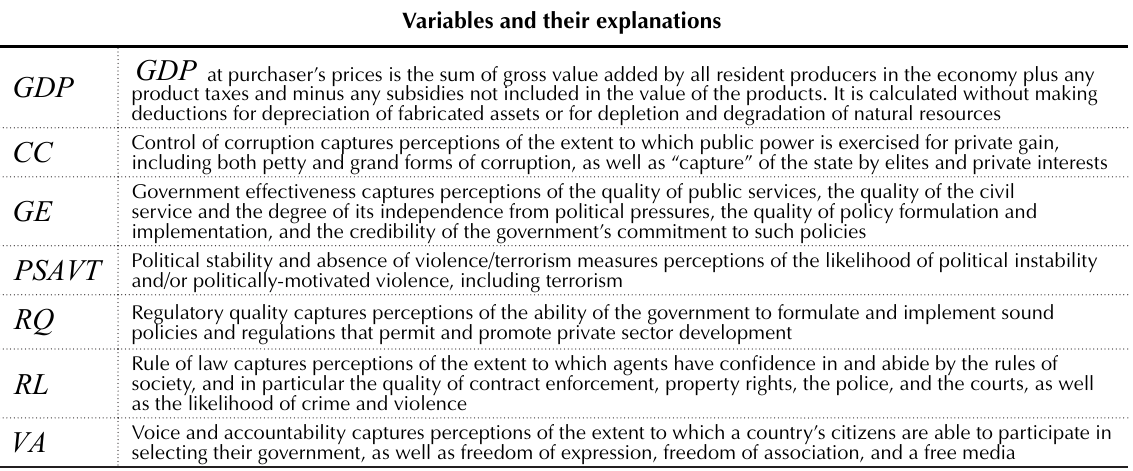
Table 4. Explanations of variables used in the regression model Source: World Bank’s Worldwide Governance and World Development Indicators databases